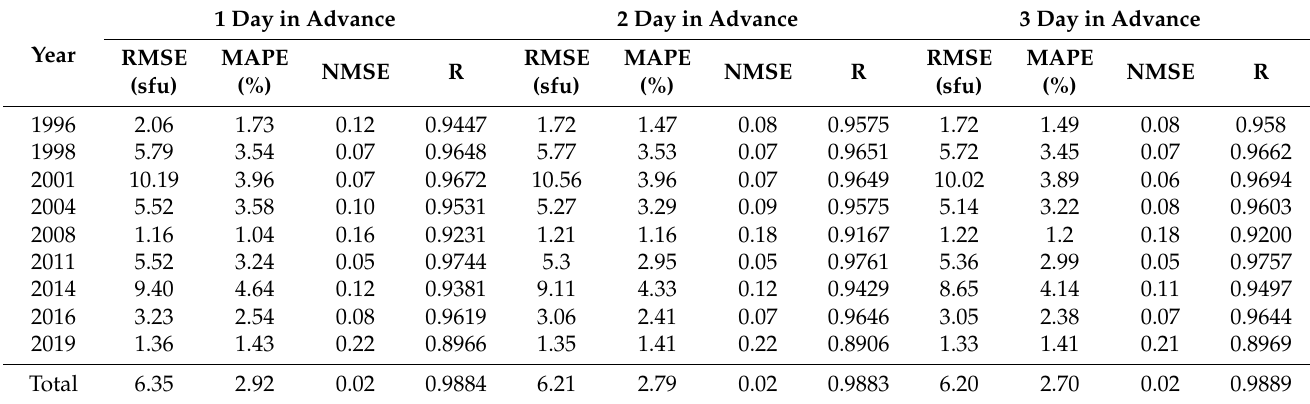
Table 2. The prediction errors (RMSE, MAPE, and NMSE) and R of our LSTM model for the F 10.7 data during 1996–2019.